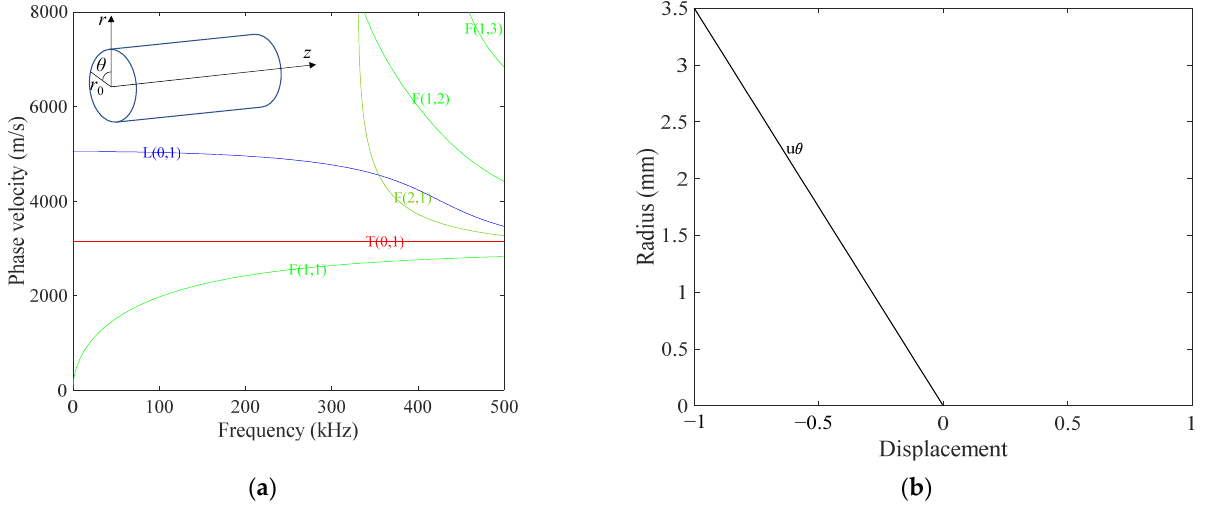
Figure 1. ( a ) Dispersion curves of a solid steel rod with a 3.5 mm radius; ( b ) the mode shape of the T(0,1) mode wave at 50 kHz.